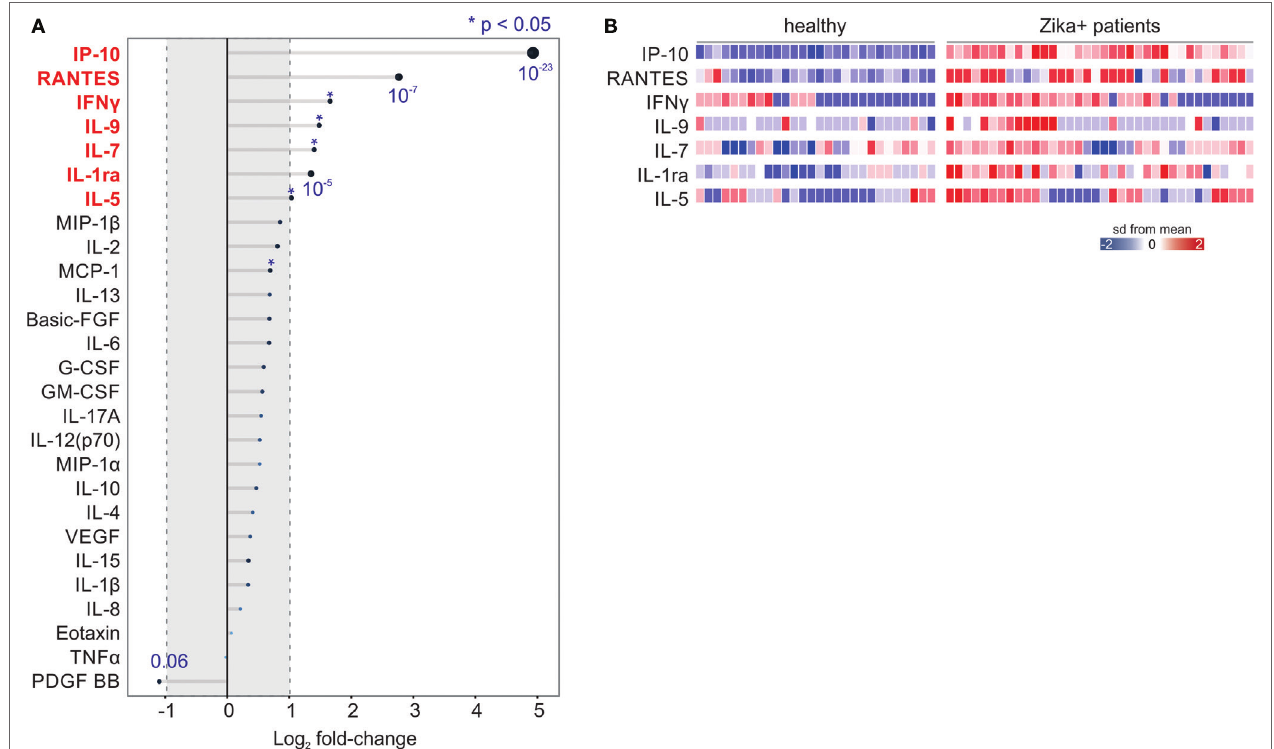
FigUre 1 | Cytokine/chemokine profiling in acute Zika virus (ZIKV) infection. (a) Differences in plasma cytokine/chemokine levels between acute ZIKV­infected and healthy subjects. Names in red represent cytokines with significantly higher levels upon infection ( p < 0.05 and greater than twofold induction). The size of the circles is proportional to the significance. p ­Values are shown in blue. (b) Individual levels of the cytokines upregulated in acute ZIKV infection. Each column represents a study subject. The levels of each cytokine/chemokine (rows) were z